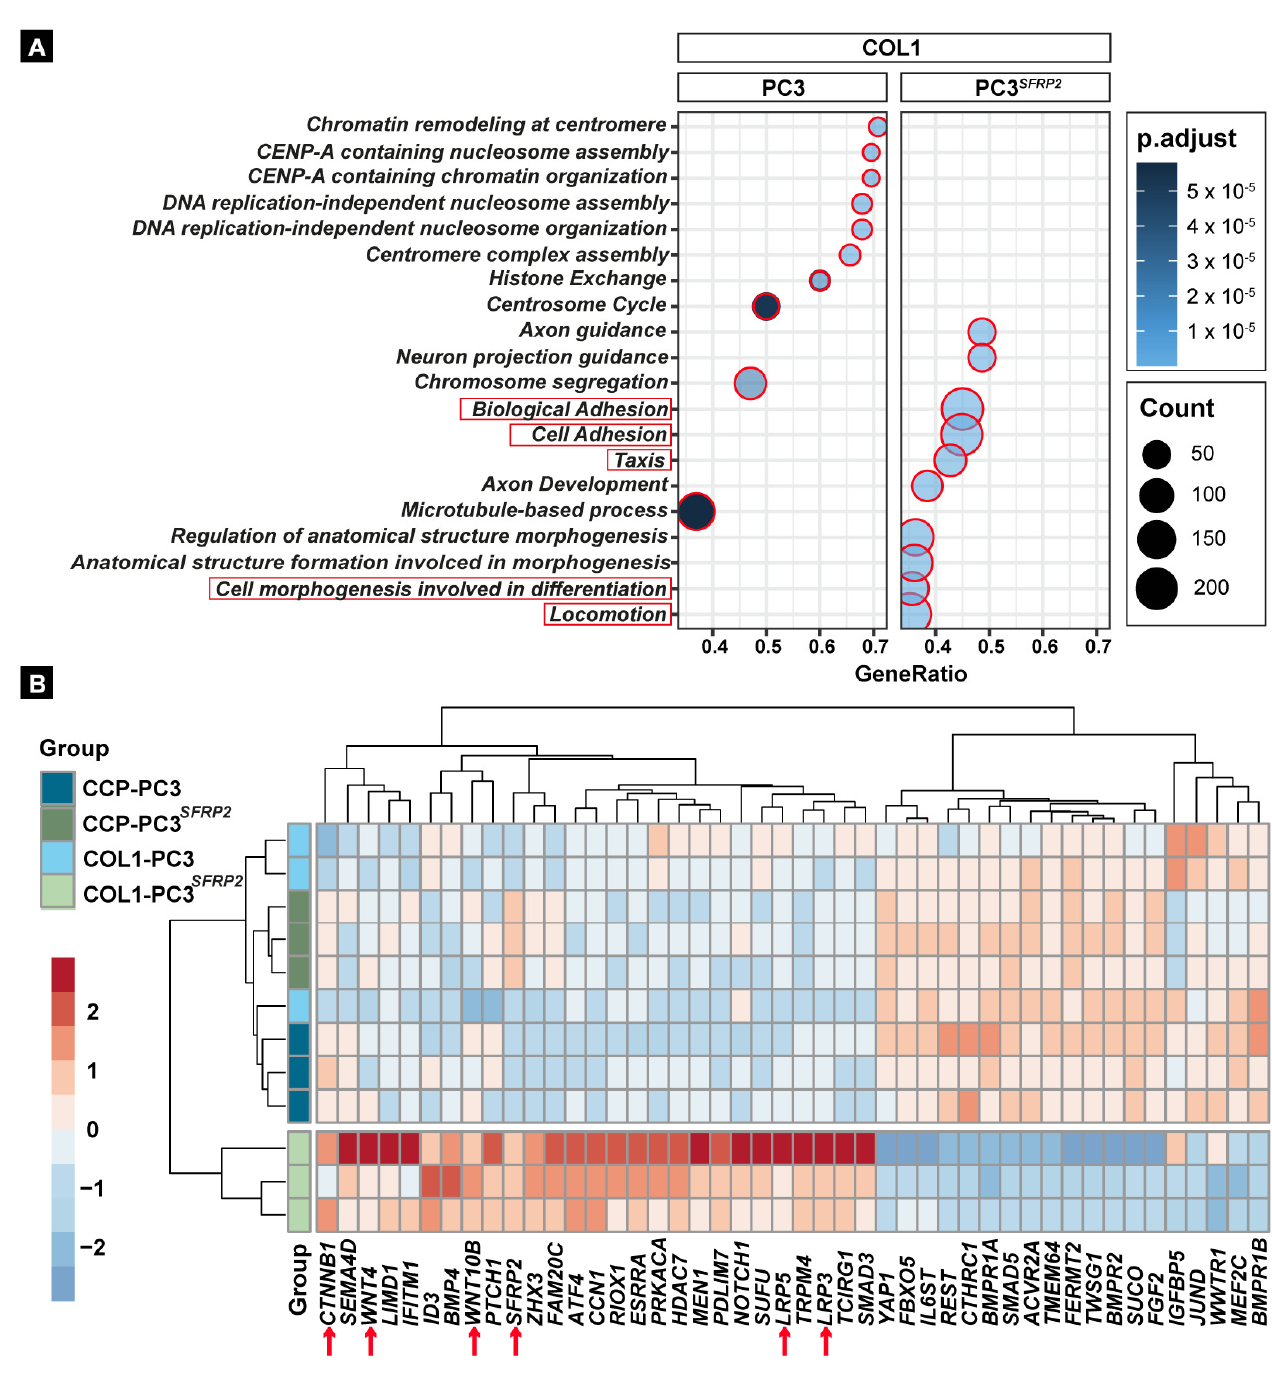
Figure 3. SFRP2 overexpression leads to osteotropic properties in PC3 cells on a COL1 surface. GO biological processes related to adhesion, taxis, and differentiation were significantly increased by SFRP2 overexpression compared to native PC3 cells when the cells were seeded on COL1 ( A ). Heatmap of osteoblast differentiation-related genes (GO:0001649) shows clear clustering of COL1-PC3 SFRP2 from all other groups ( B ). Arrows indicate WNT signaling-related gene expression in osteoblast differentiation.